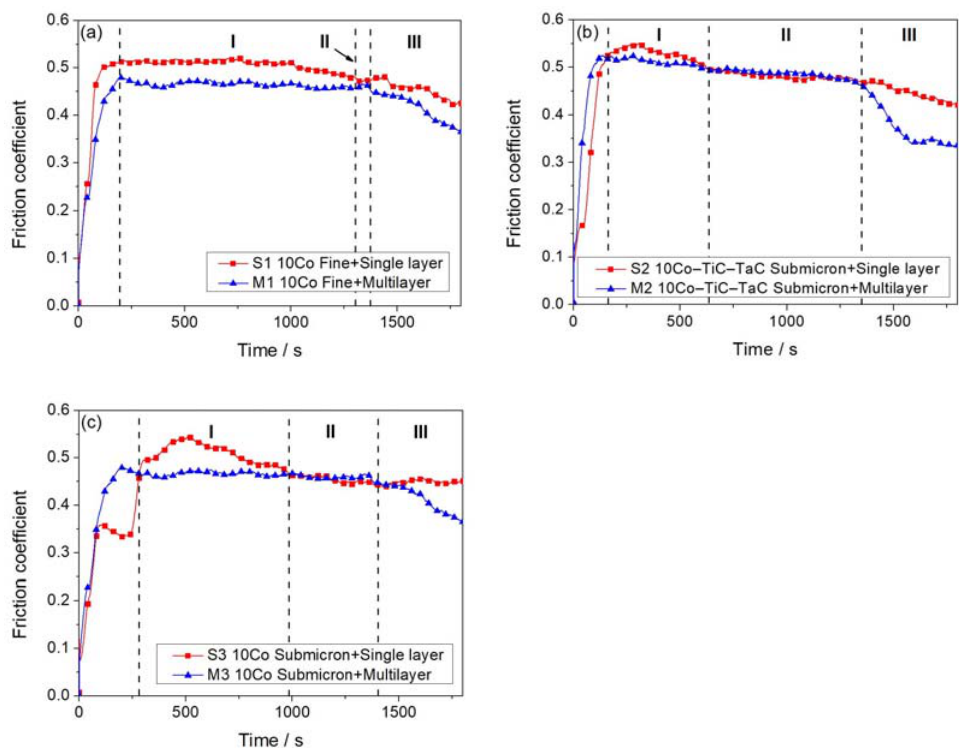
Figure 6. Comparison of friction coefficients (corresponding to three wear stages I~III) between the single ‐ layer and multilayer films: ( a ) M1 vs. S1, ( b ) M2 vs. S2, ( c ) M3 vs. S3. single-layer and multilayer films: ( a ) M1 vs. S1, ( b ) M2 vs. S2, ( c ) M3 vs.